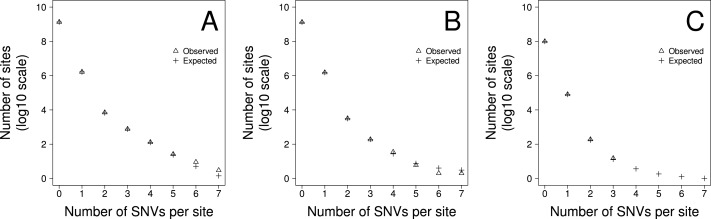
The fit of the observed recurrent SNV distribution to expected distribution under the favoured model, 2b, for (A) TE, (B) NTE and (C) EX genomic fractions